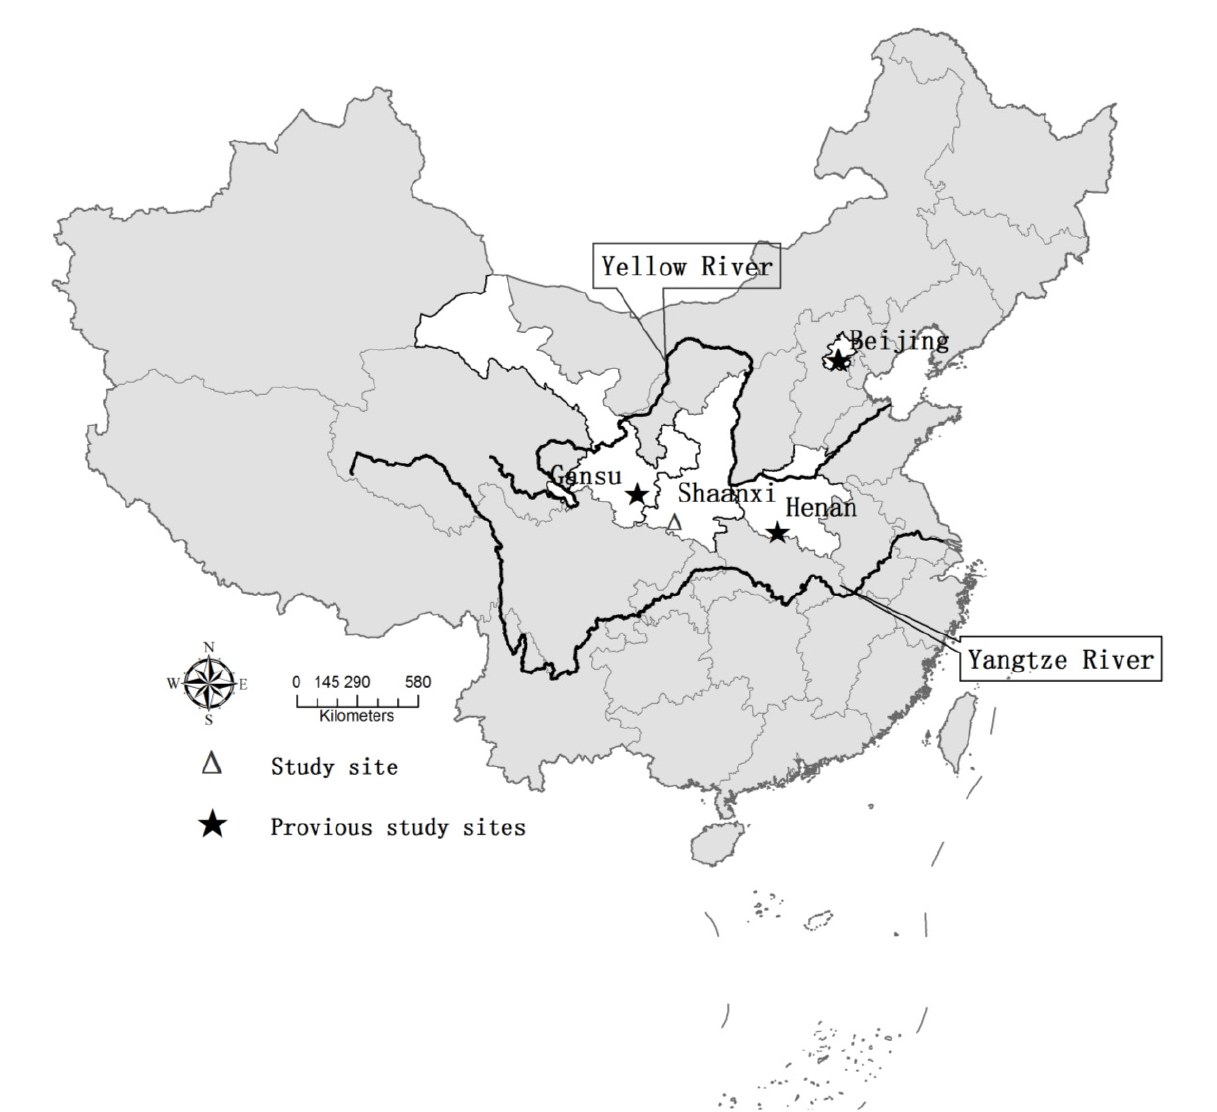
Figure 1. Site distribution of studies on Chinese cork oak allometric equations include Xiaolong Mountains, Gansu Province; the Xishan Mountains, Beijing; the Baotianman Natural Reserve, Henan Province; and the present study at Shanyang Country, Shanxi